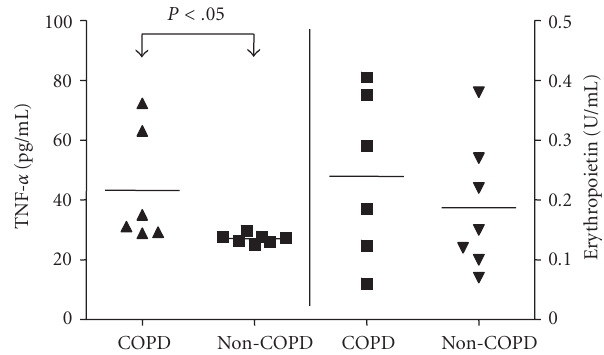
Figure 2: TNF- α - and EPO levels in EBC. In COPD, TNF- α levels were significantly higher compared to OSA and lung healthy pa- tients (pooled as non-COPD), calculated using Mann Whitney U Test, P < . 05 denotes significance, horizontal line =